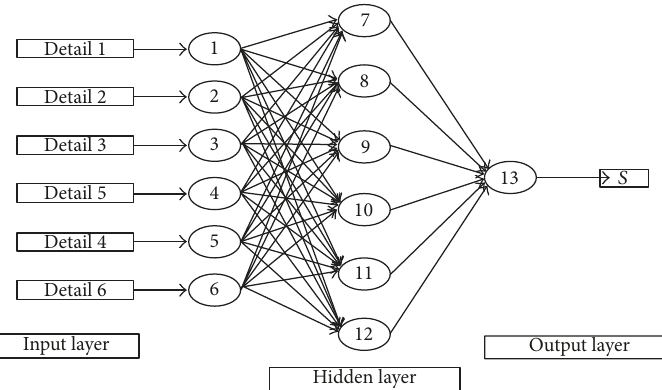
Figure 6: Proposed neural network architecture.